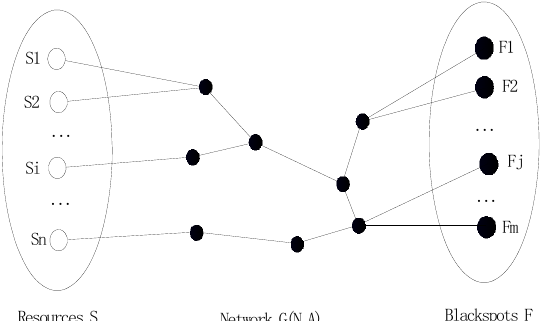
Figure 1. Incident occurrence and allocation of response resources in a sparse network.